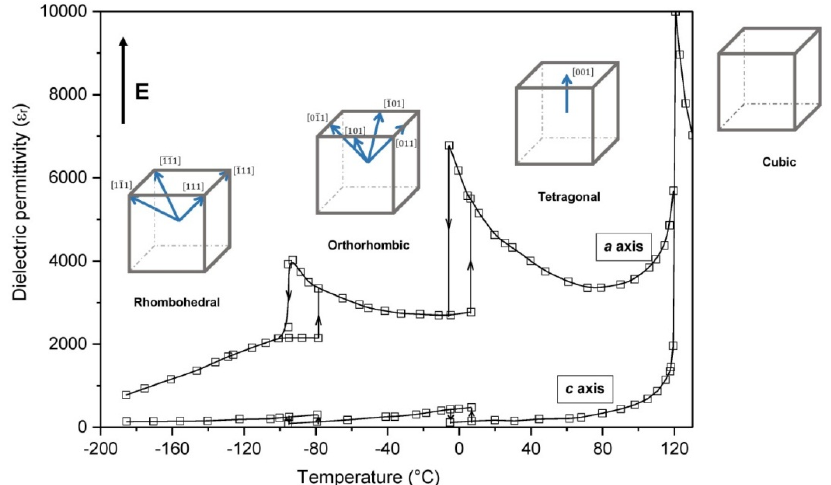
Figure 2. Phase transition temperatures at the dielectric permittivity curves of BaTiO 3 and equivalent polar directions under an applied electric field ( E ) for the polymorphic phases related to the cubic prototype perovskite structure.